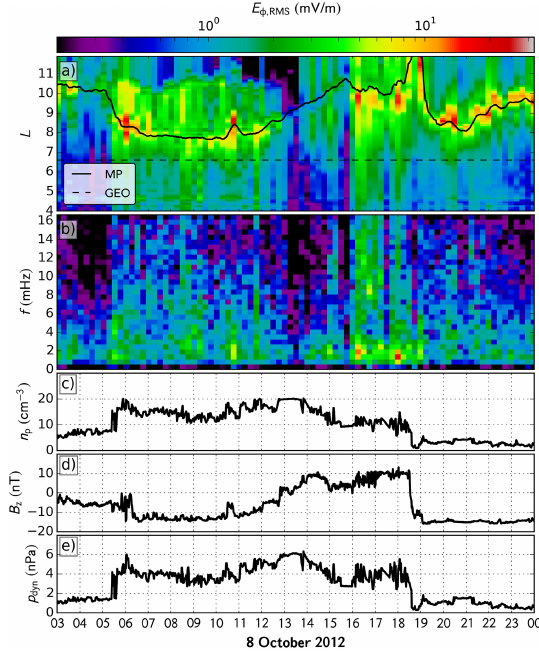
Figure 1. Power spectrum analysis of LFM-RCM run for 8 Octo- ber 2012 storm along Sun–Earth line of azimuthal component of electric field. Panel (a) is ULF power between 0 and 16mHz as a function of radial distance in SM coordinate system with magne- topause (solid line) and geostationary (dashed line) location over- plotted. Panel (b) is mean ULF wave power from L = 4 to just inside the magnetopause as a function of frequency. Panels (c–d) are corresponding solar wind parameters used as upstream bound- ary conditions for LFM-RCM simulation. This figure along with Figs. 2 and 3 reanalyze the data shown in Hudson et al. (2014b) to exclude power in panel (b) which is dominated by magnetopause fluctuations; thus only power inside the black curve in (a) minus 1 R E is plotted in (b)